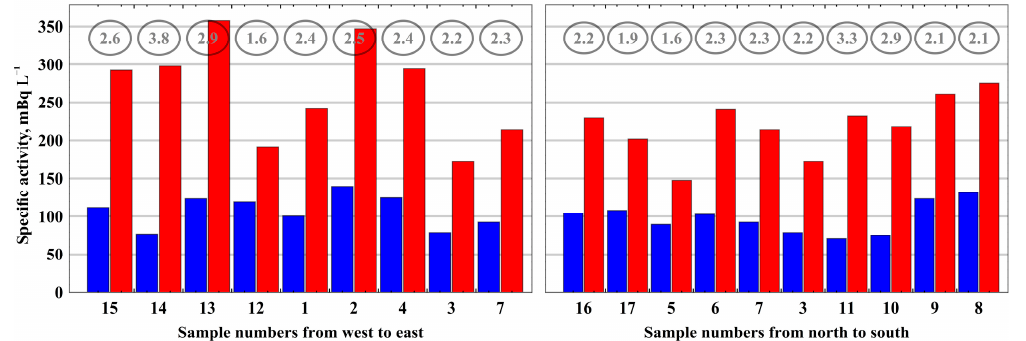
Figure 5. Spatial distribution of specific activities of 7 Be and 210 Pb atm at sampling points depending on longitude and latitude.